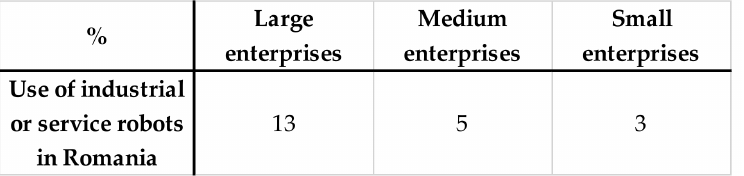
Figure 4. Use of industrial or service robots in Romania, for each enterprise size, 2020. Source: Au- thor’s Contribution. Data retrieved from Eurostat. Robotics and 3D Printing Data, https://ec.europa. eu/eurostat/databrowser/bookmark/f29db2df-2e19-4bfd-8bb4-af630dc3e907?lang=en, accessed on 9 January